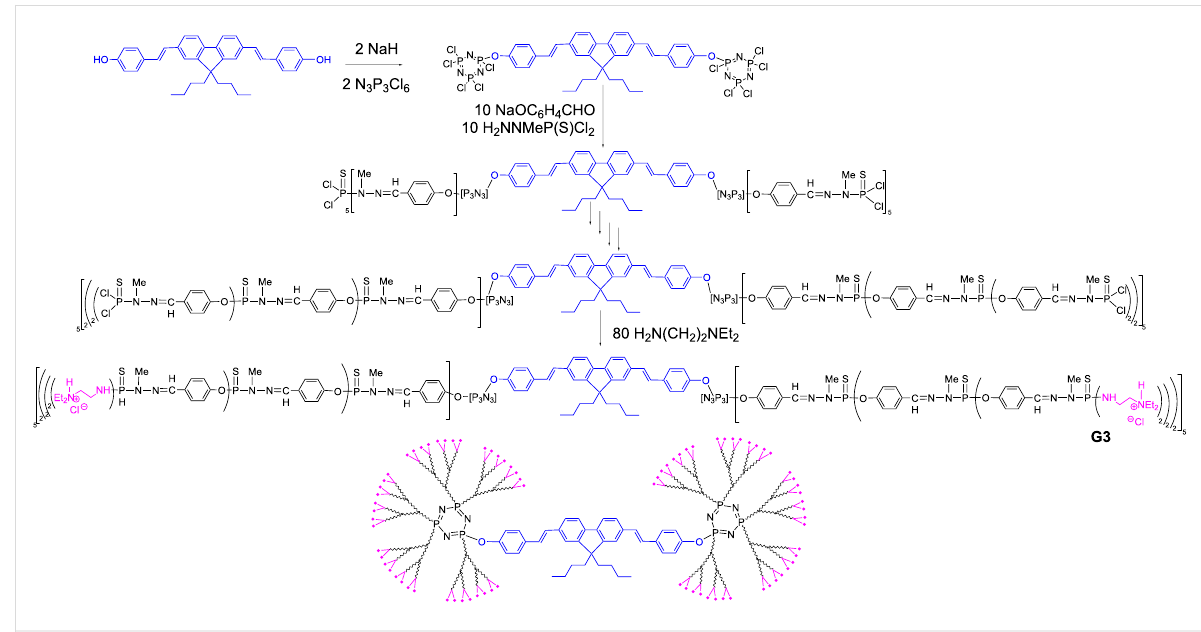
Scheme 4: Dumbbell-like dendrimers (third generation) having one TPA fluorophore at the core, and ammonium terminal functions.